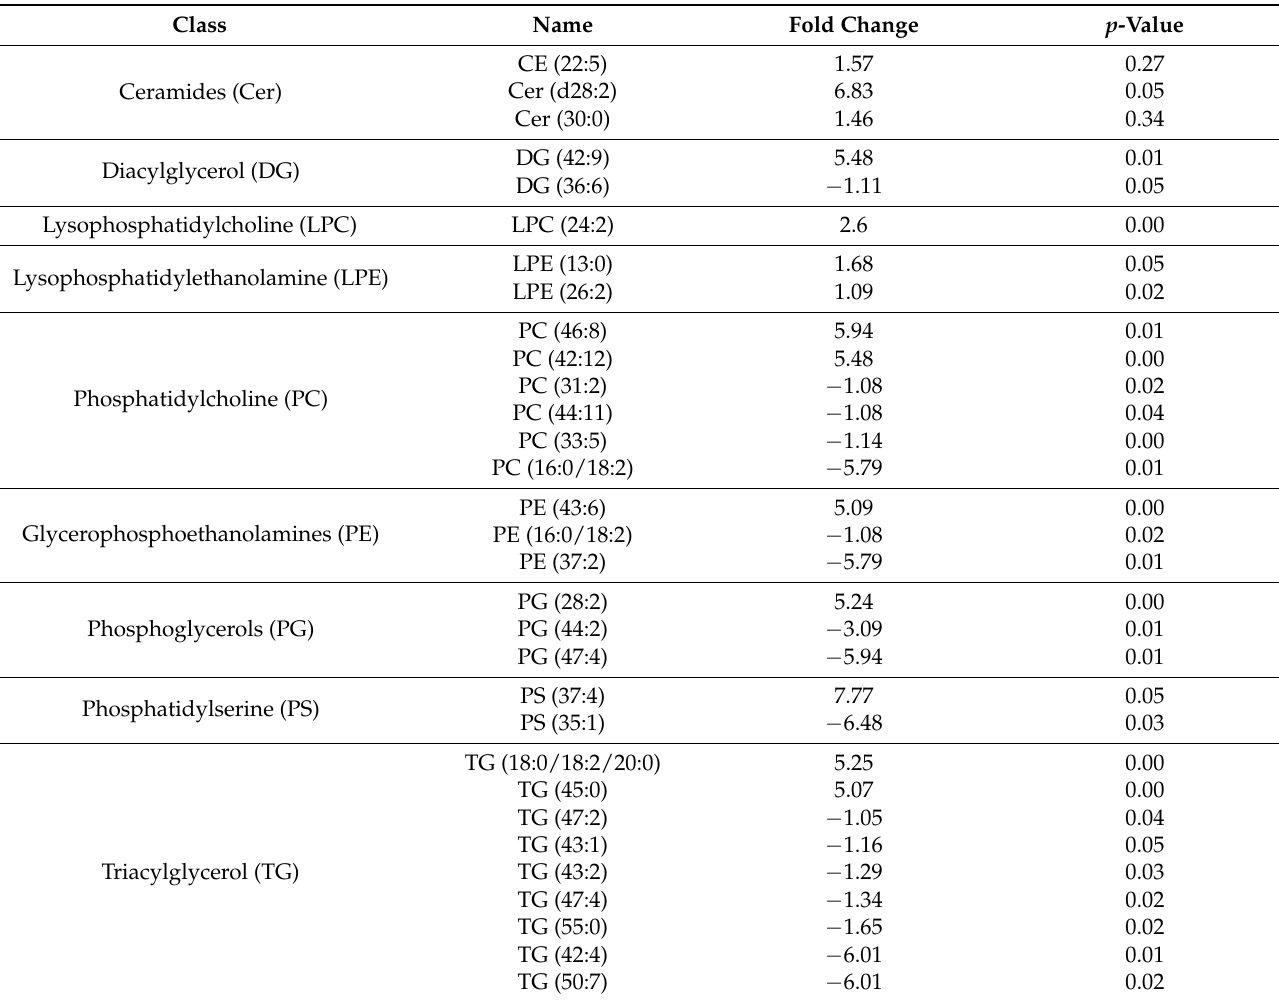
Table 1. Lipid species were significantly regulated in spheroids treated with 45 µ M palmitic acid and 65 µ M oleic acid compared to control grown in standard growth media. Statistical analysis was performed using a Student’s t -test built in the Metaboanalyst v 5.0 software, p < 0.05, n =